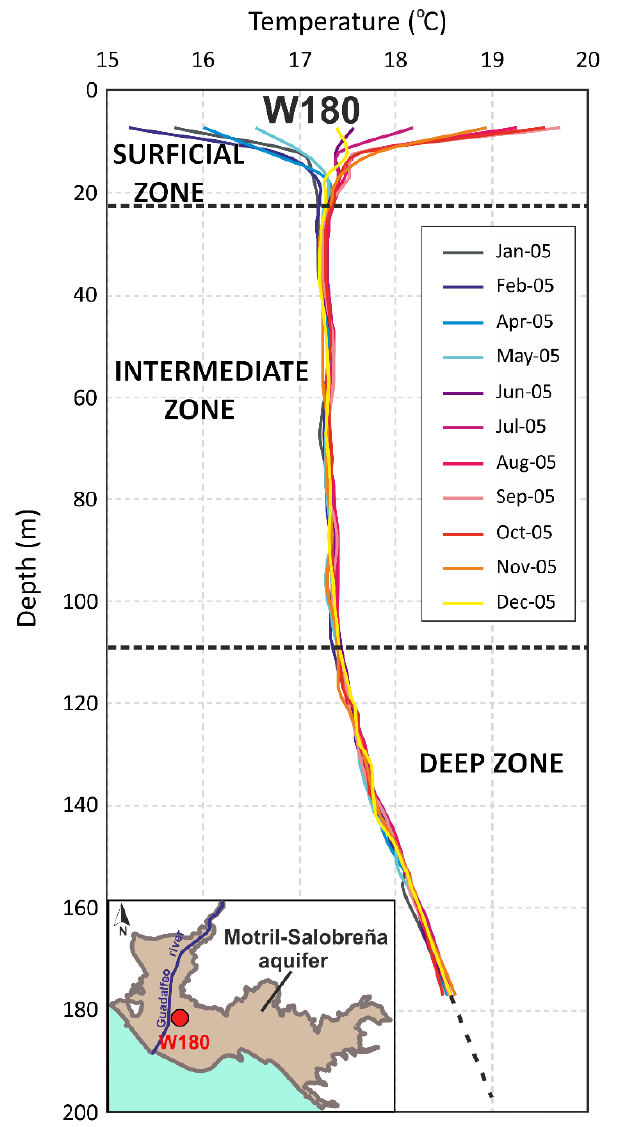
Figure 3. Vertical temperature profiles measured in the Motril-Salobreña aquifer, obtained from the observation well W180 located in Figure 2.